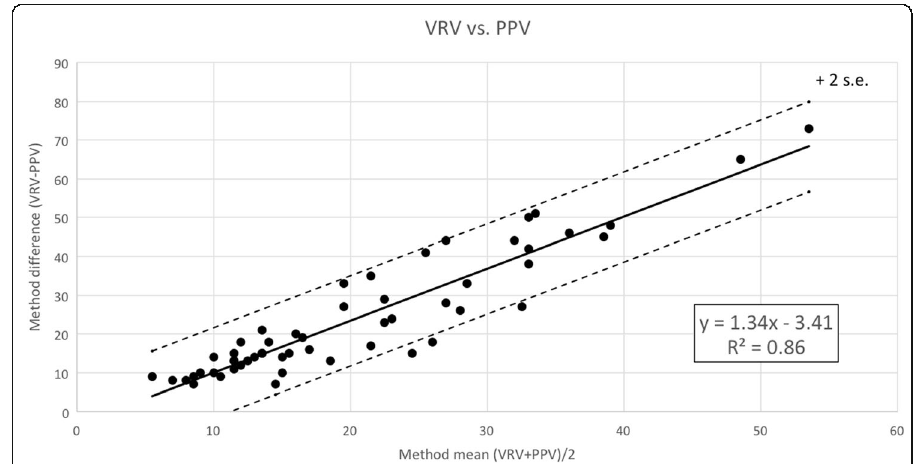
Fig. 6 Bland – Altman plots on agreement measures between VRV and PPV. It shows the biggest difference between VRV and PPV around the VRV cutoff point for fluid responsiveness. VRV venous return variation index, PPV pulse pressure variations